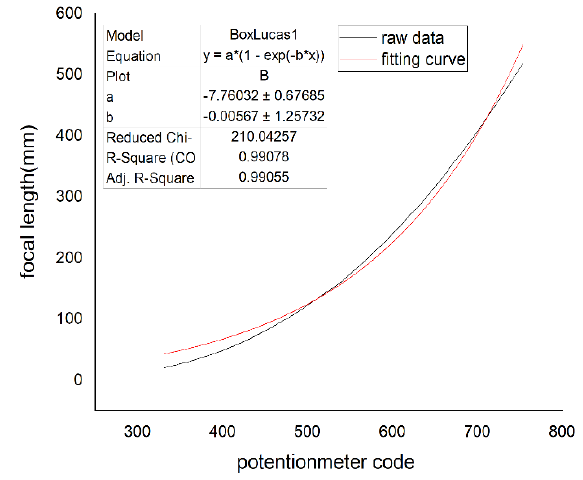
Figure 19. Exponential fitting.